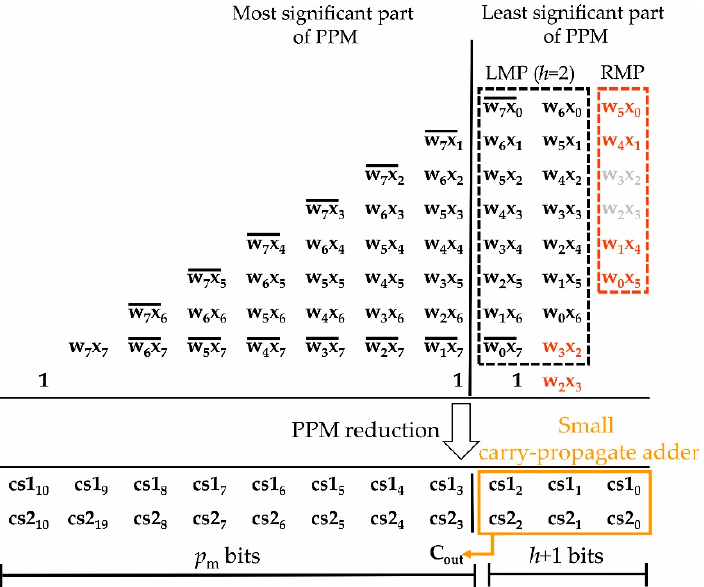
Figure 7. Fixed-width multiplier with the output expressed in carry-save format. The small carry- propagate adder processes the h + 1 LSBs of cs 1 and cs 2 to compute C out .